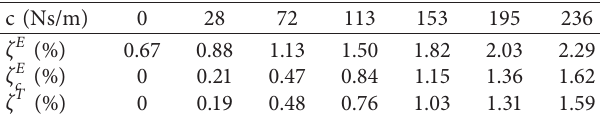
Table 1: Viscous damping coefficient of eddy current damper. Number of magnets